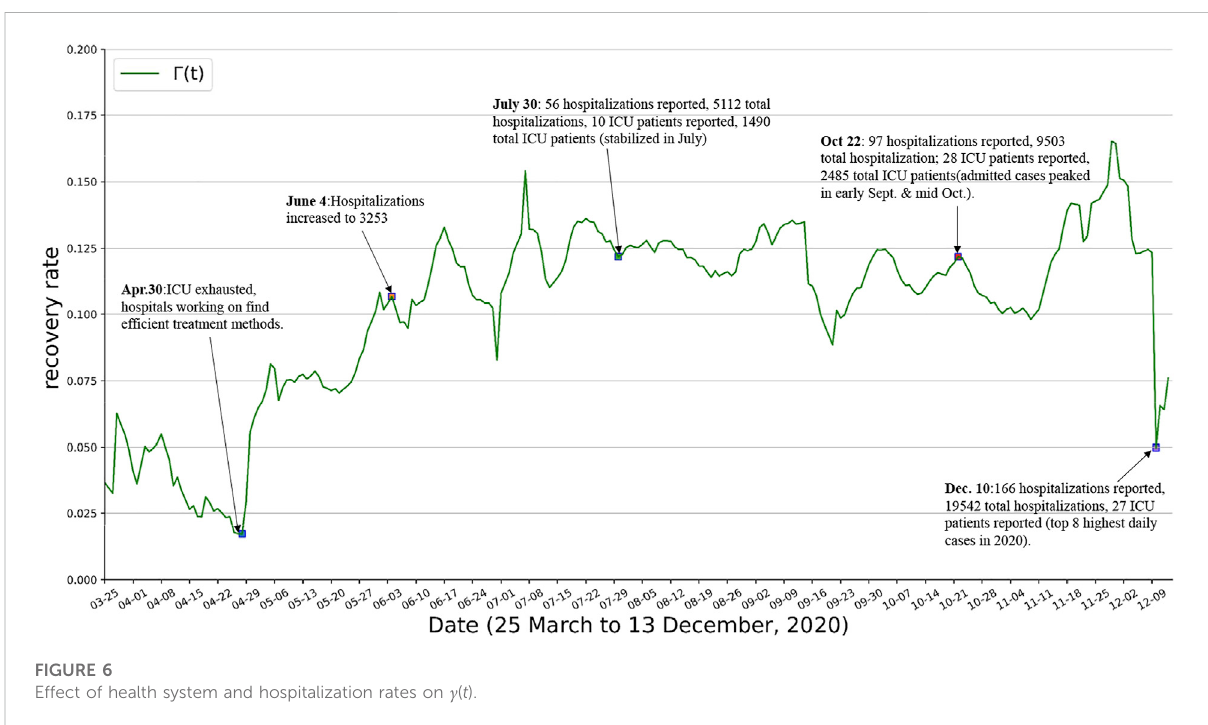
FIGURE 6 Effect of health system and hospitalization rates on γ ( t ).